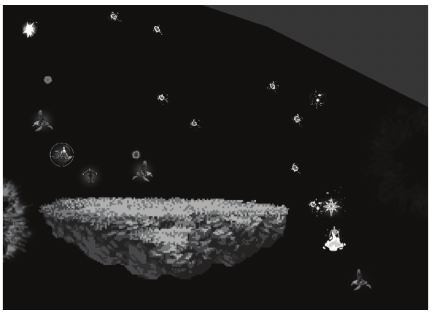
Figure 5: A snapshot from